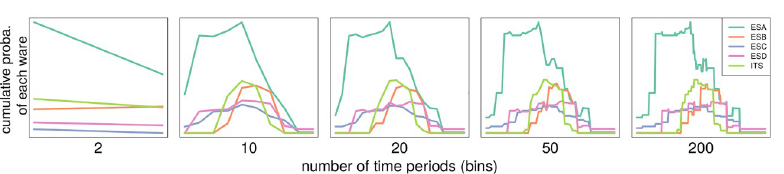
Fig 3. Impact of the number of bins on the data pattern. The number of bins used to describe the data increases from left (2 bins) to right (200 bins).